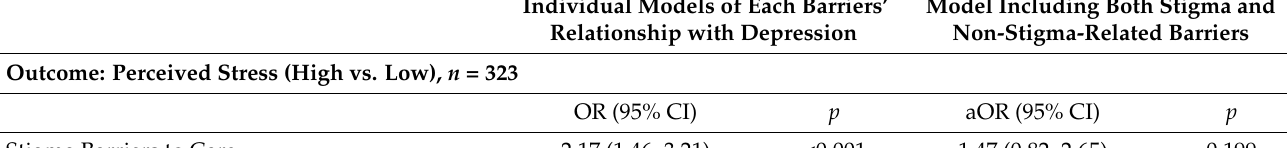
Table 3. Logistic Regression Associating Barriers to Accessing Mental Healthcare with Outcomes of Perceived Stress ( n = 323) and Depression ( n =